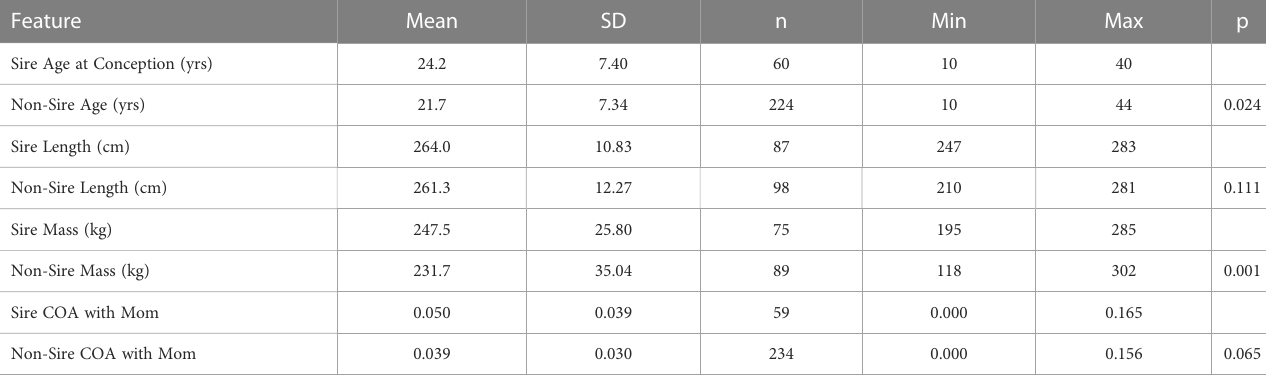
TABLE 4 Comparisons of features of known sires and non-sire adult male associates of presumed receptive females during the month surrounding their estimated date of